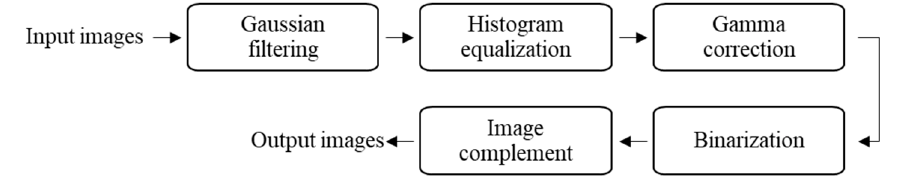
Figure 4. Flow of pre-processing.